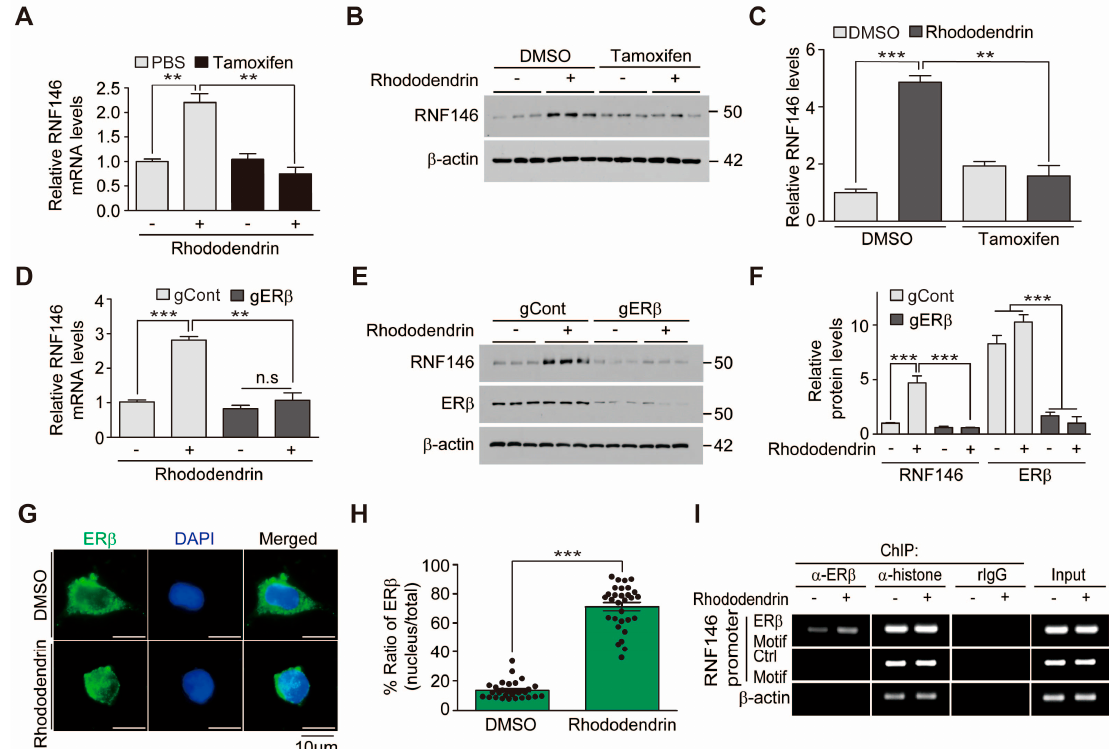
Figure 3. RNF146 expression induced by rhododendrin is mediated by ER β activation. ( A ) Quantification of relative RNF146 mRNA expression levels (normalized to those of GAPDH) in SH-SY5Y cells treated with rhododendrin (10 μ M, 37 h) in the presence or absence of the ER inhibitor tamoxifen (1 μ M, 8 h) determined by RT-qPCR ( n = 3). ( B ) Representative Western blot showing that rhododendrin (10 μ M, 37 h)-mediated induction of RNF146 expression is blocked by tamoxifen treatment (1 μ M, 8 h). ( C ) Quantification of relative RNF146 expression levels (normalized to those of β -actin) in the experimental groups in panel B ( n = 3). ( D ) Quantification of relative RNF146 expression levels (normalized to those of GAPDH) in SH-SY5Y cells treated with rhododendrin (10 μ M, 37 h) determined by RT-qPCR. ER β expression was knocked down by CRISPR-cas9-mediated deletion of ER β (85 h). sgRNA to EGFP was used as CRISPR-cas9 transfection control ( n = 3). ( E ) Representative Western blot showing that rhododendrin (10 μ M, 37